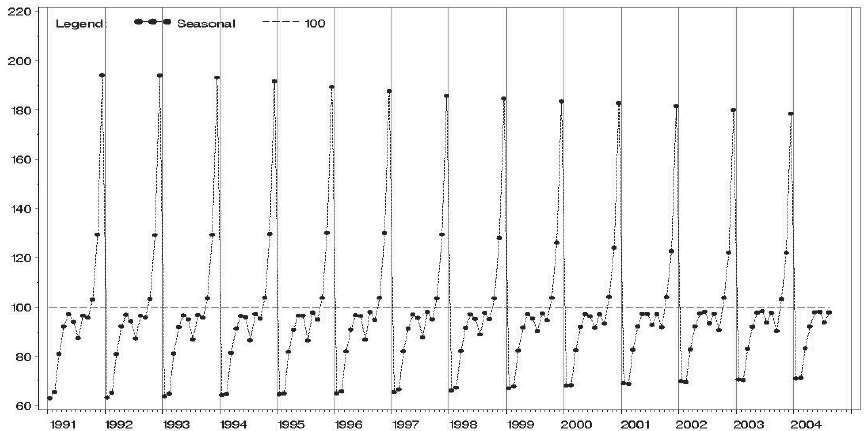
Fig. 1 – Seasonal pattern of Sales by Canadian Department